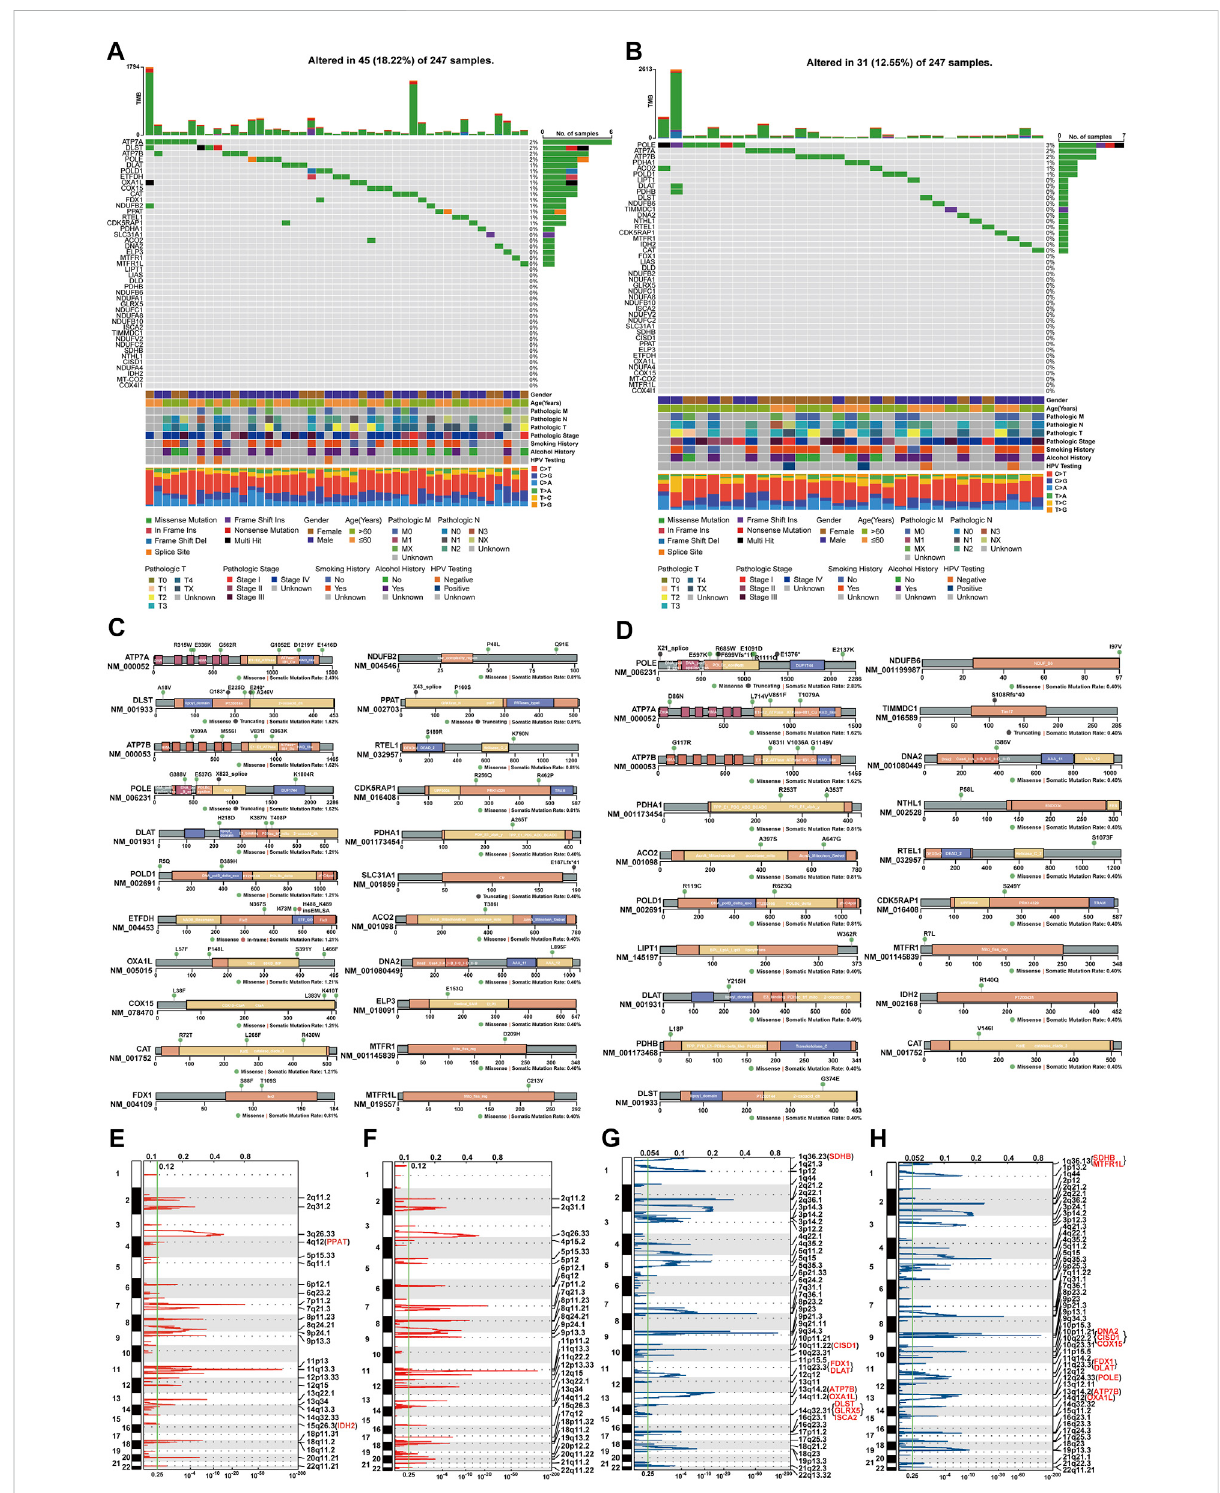
FIGURE 2 Analysis of gene variants of CRGs in HNSC (A , B) Mutational oncoplot of CRGs in TCGA- fi rst (A) and TCGA-second (B) cohorts (C , D) Changes in proteinsstructureofCRGsduetosomaticmutationsinTCGA- fi rst (C) andTCGA-second (D) cohorts (E , F) Ampli fi cationofchromosomalsub-bands of CRGs in TCGA- fi rst (E) and TCGA-second (F) cohort (G , H) Chromosomal deletion of sub-bonds of CRGs in TCGA- fi rst (G) and TCGA-second (H)